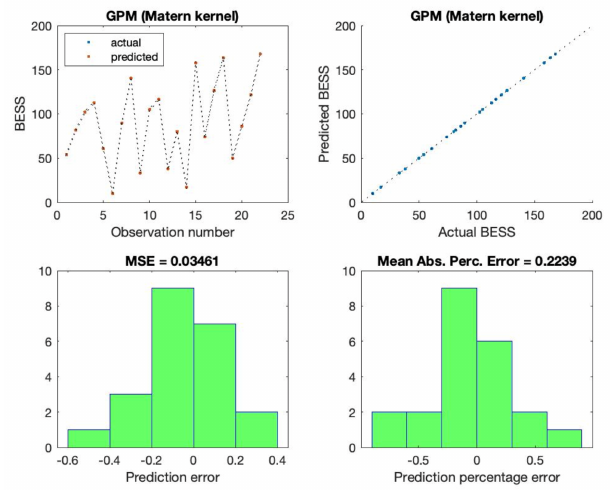
Figure 13. Machine learning results of the GPM mdl for